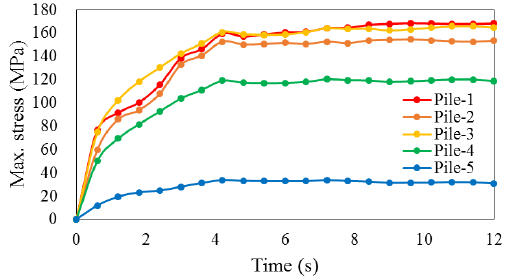
Figure 13. Variation in stress acting on piles according to time during the fifth cycle at cover depth of 1.5 m.